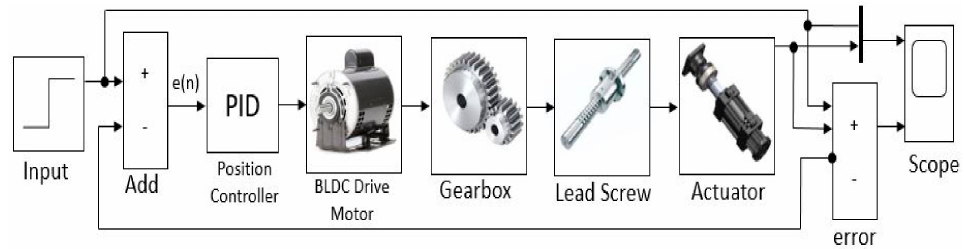
Figure 6. Control Simulink model of the electromechanical